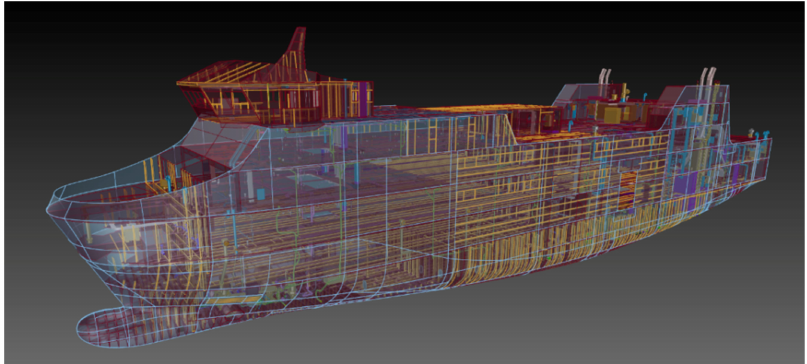
Figure 3. Complete 3D view of a ferry in a CAD